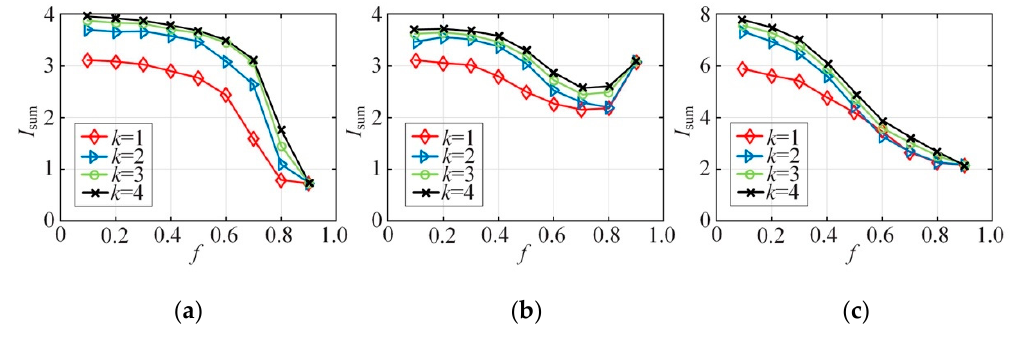
Figure 5. Synthesized dataset 𝐼 sum vs. f : ( a ) NLTCS, ( b ) Adults, ( c ) TPC-E.